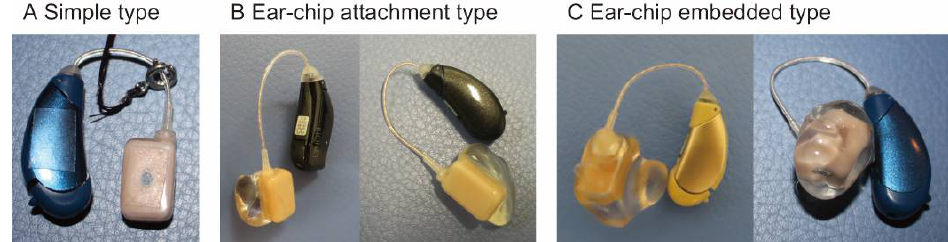
Figure 4. Cartilage conduction hearing aids (HB-J1CC, Rion Co Ltd., Kokubunji, Tokyo, Japan) have three transducer types: ( A ) simple-attachment, ( B ) ear-chip attachment, and ( C ) ear-chip ( A ) simple-attachment, ( B ) ear-chip attachment, and ( C ) ear-chip embedded.